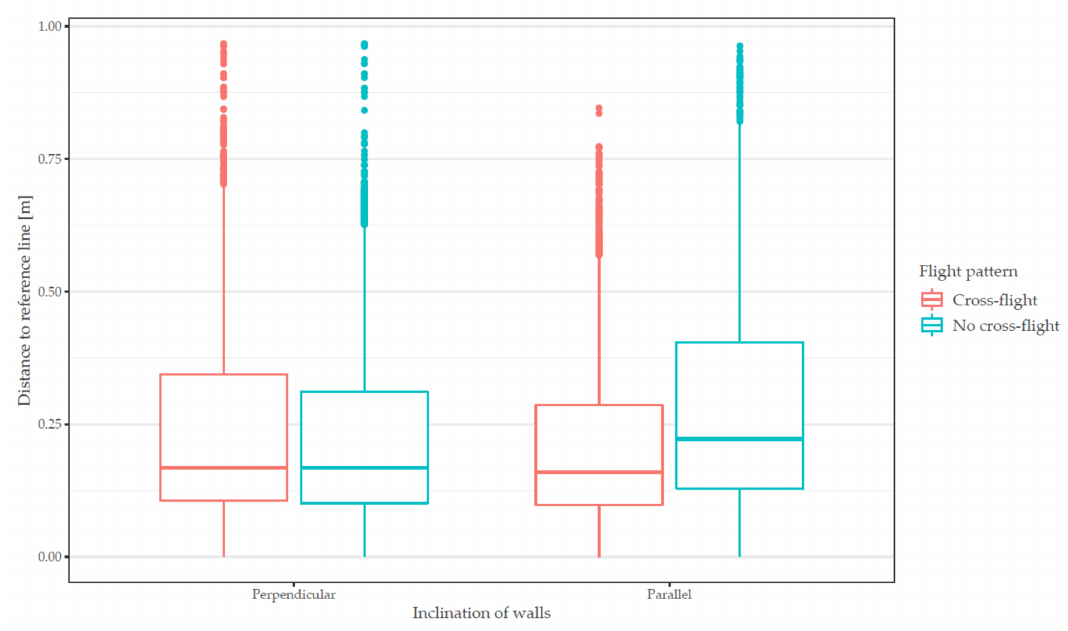
Figure 12. Box-whisker plot of distances to reference lines separated according to the direction of walls (parallel or perpendicular to the flight direction). Box represents the interquartile range (IQR) with the median; whisker represent 1.5 IQR, points represent